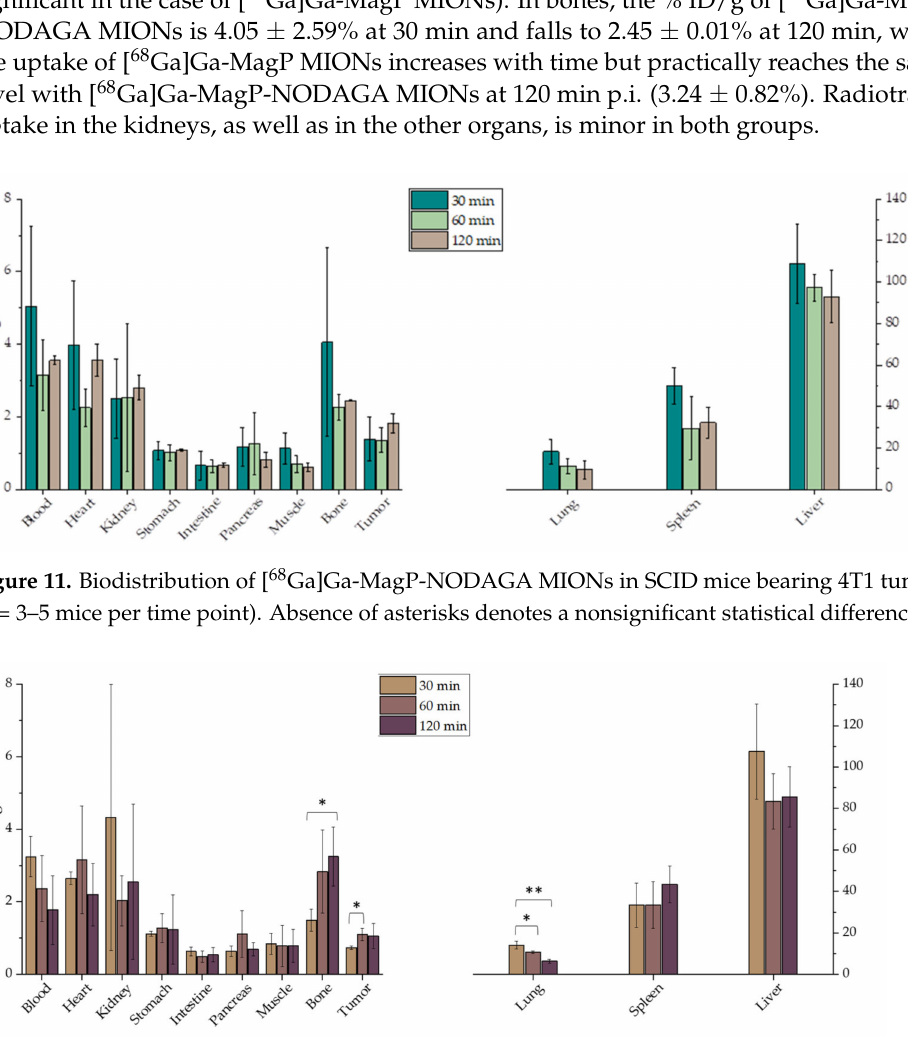
Figure 12. Biodistribution of [ 68 Ga]Ga-MagP MIONs in SCID mice bearing 4T1 tumors ( n = 3–5 mice per timepoint). Asterisks indicate the statistical significance of the difference between the results (* p < 0.05, ** p < 0.01, *** p < 0.001). Absence of asterisks denotes a nonsignificant statistical